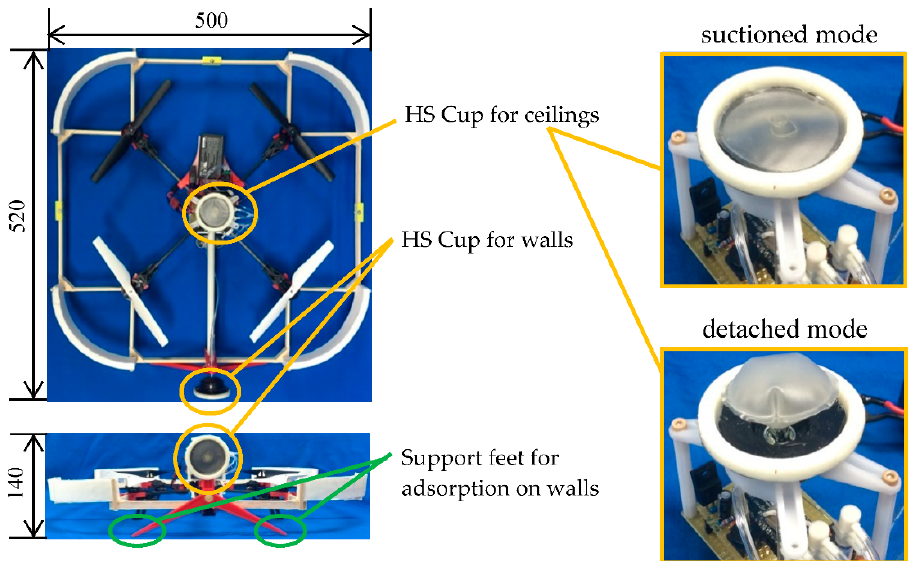
Figure 9. Drone with two HS cups: one for walls and one for ceilings. Support legs were installed to extend the moment of the supporting force by the HS cup when attached to a wall surface.